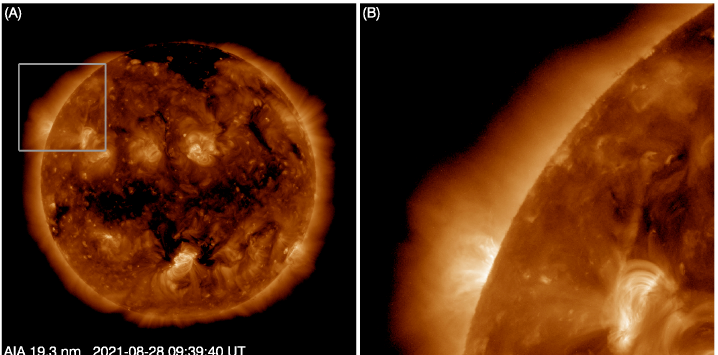
Figure 1. ( A ) is the 19.3 nm solar image observed by AIA at 09:39:40 UTC on 28 August 2021, and ( B) is the local enlarged image in the rectangular box in A. The observation time is marked in the lower left corner of A.